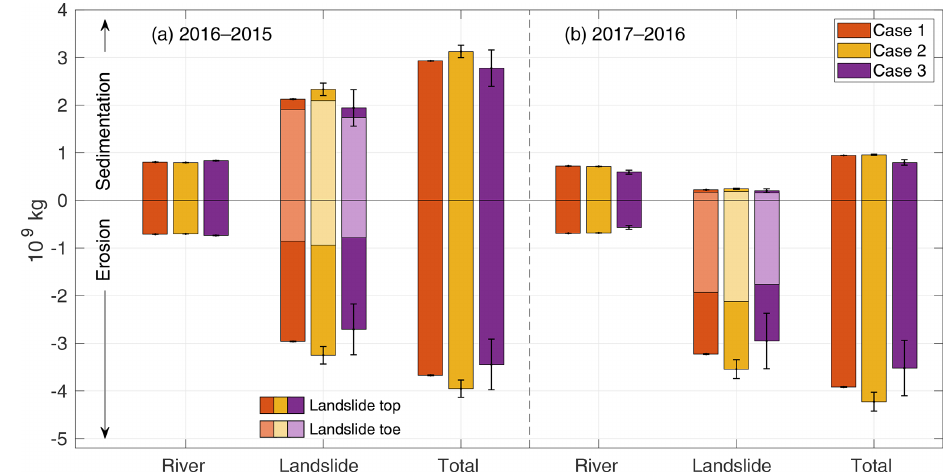
Figure 10. Estimation of the mass of sediment redistributed between 2016 and 2015 and between 2017 and 2016 in cases 1, 2 and 3 (red, yellow and purple, respectively; same color code as in Fig. 9). The mass estimation is shown for the river, the landslide and their sum (total). The error bars are computed by multiplying the volume variations from the DSM with the density uncertainties (Table 6). The landslide volumes distinguish the top and the toe of the landslides with a stacked bar plot